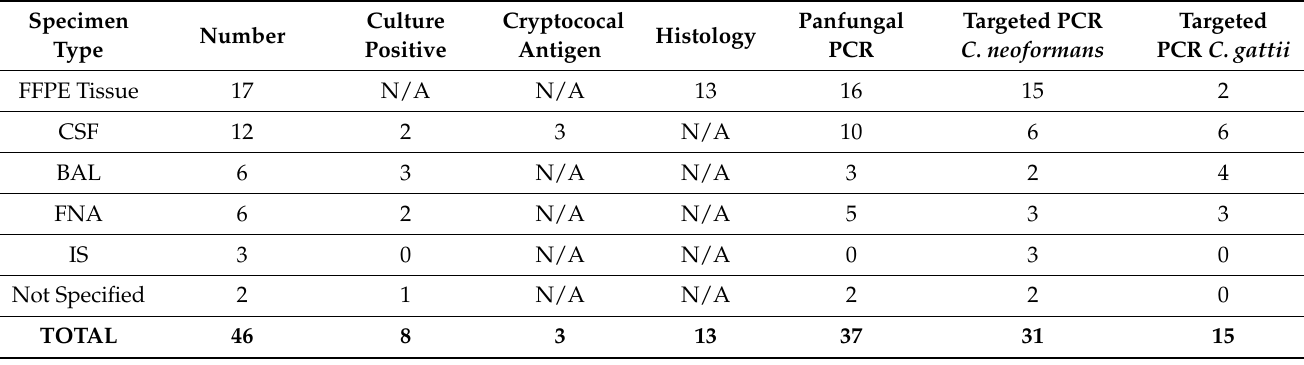
Table 1. Results of Cryptococcus -specific PCR compared with other diagnostic